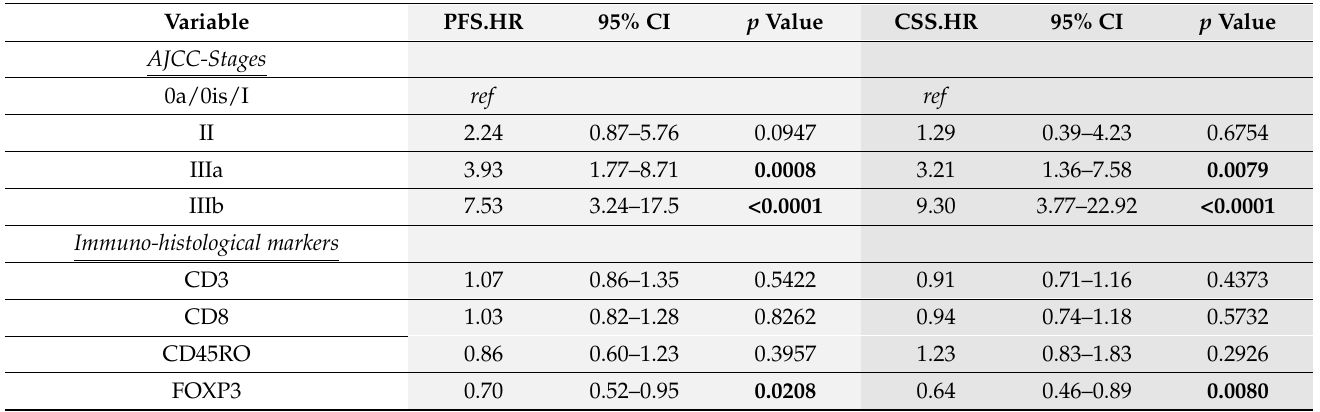
Table 3. Multivariable Cox-Regression Analysis/AJCC model + all mIS